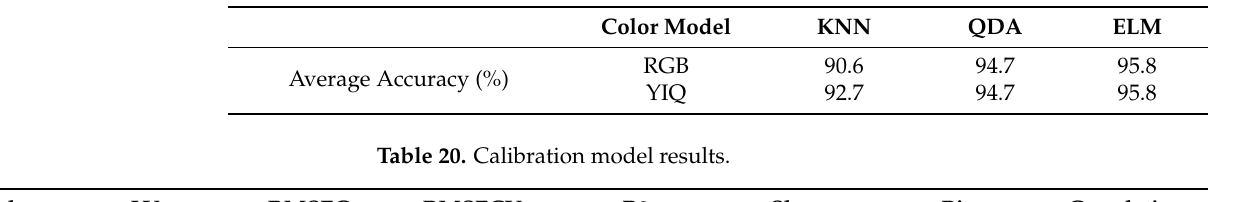
Table 19. Average accuracy according to the color classifier and model.